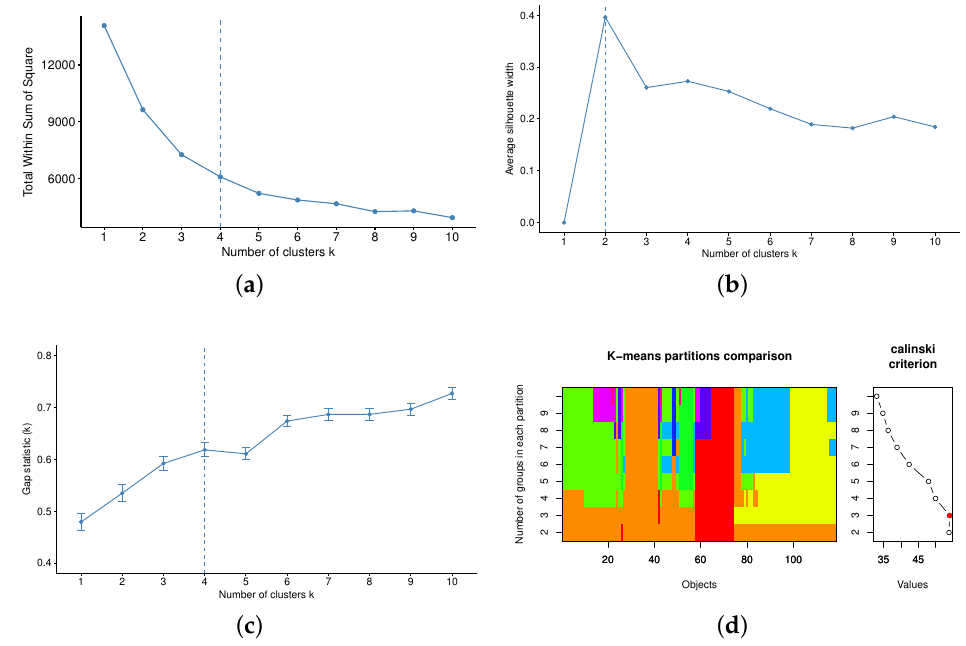
Figure 2. Determine optimal K with different methods for SFD-out data, which shows that optimal number of clusters depends on the clustering algorithms and metrics. (a) Elbow method [46]: K = 4; (b) Silhouette method [47]: K = 2; (c) Gap statistic method [48]: K = 4; (d) Calinski criterion [49]: K =